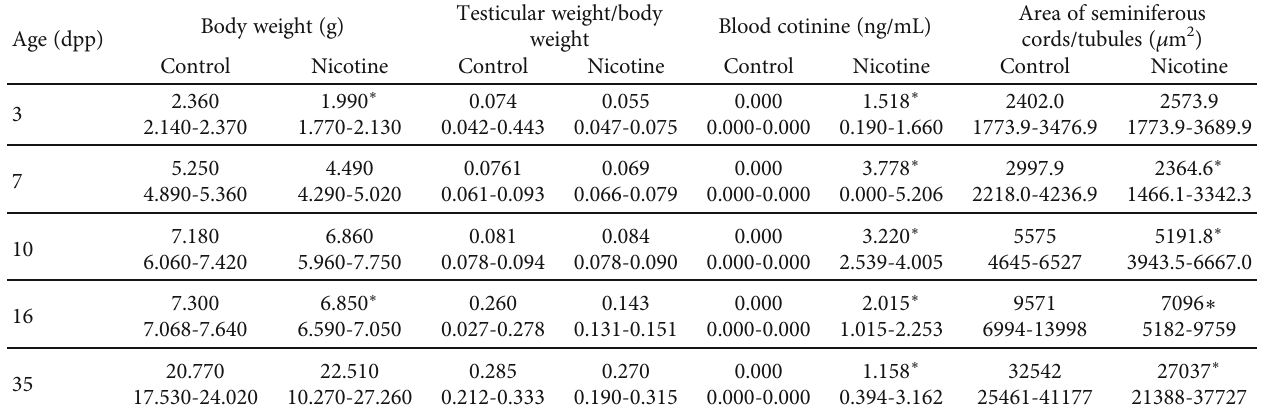
Table 1: Evaluated parameters (median and interquartile ranges) in control and nicotine-exposed animals. Body weight Age (dpp)